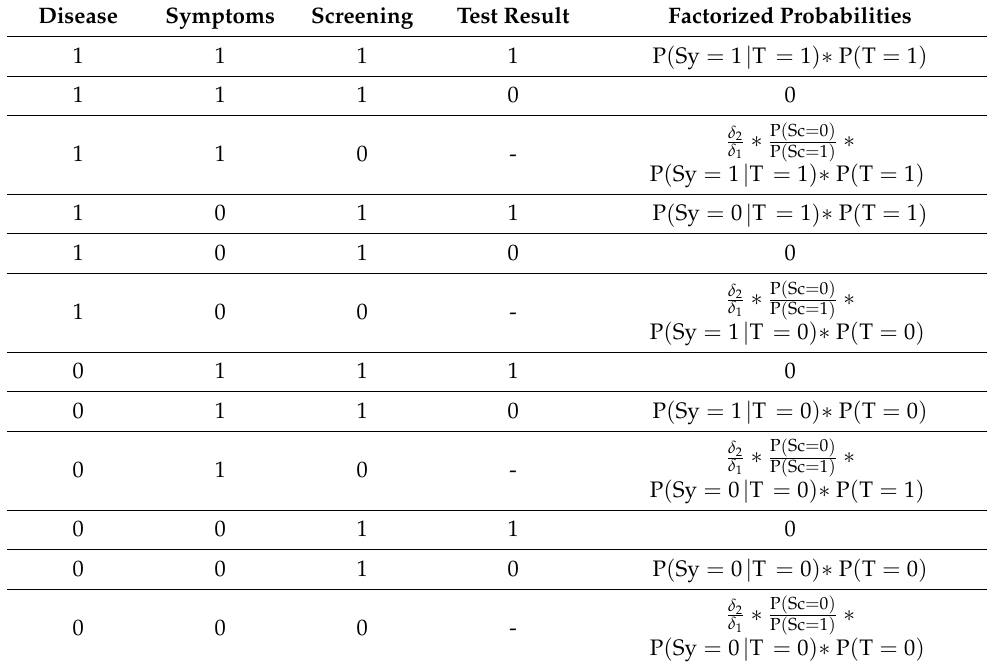
Table 1. Derivation of the joint probability distribution P (D, Sy, Sc, T) using chain rule of probability. Disease Symptoms Screening Test Result Factorized